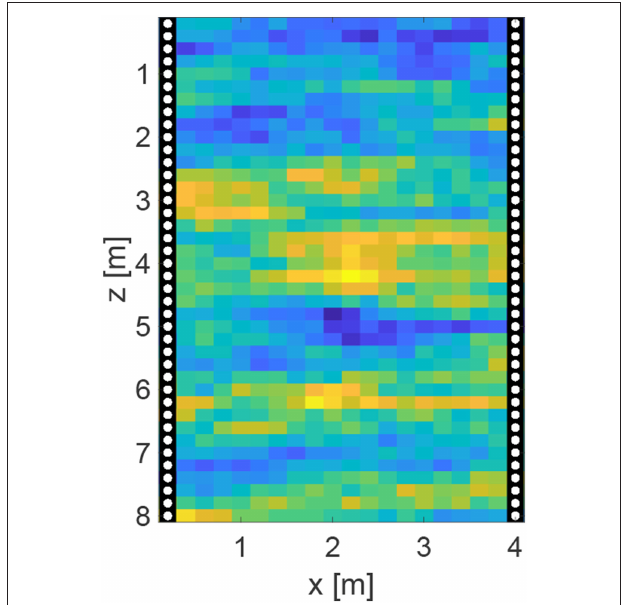
FIGURE 1 | Considered crosshole GPR survey configuration with boreholes shown as black lines. Transmitter and receiver positions are shown as white dots and distributed every 0.2 m down the